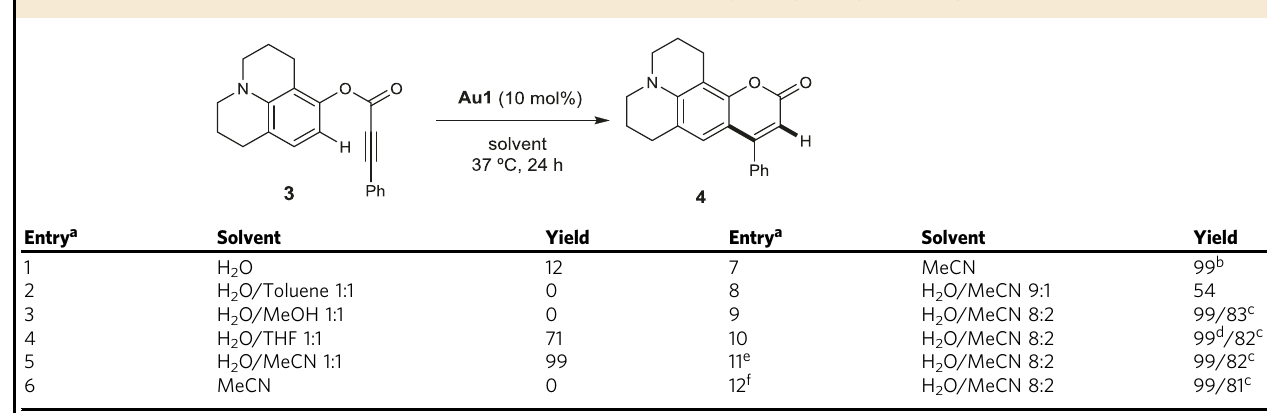
Table 1 In fl uence of the solvent and reaction conditions in the Au1-catalyzed hydroarylation of precursor